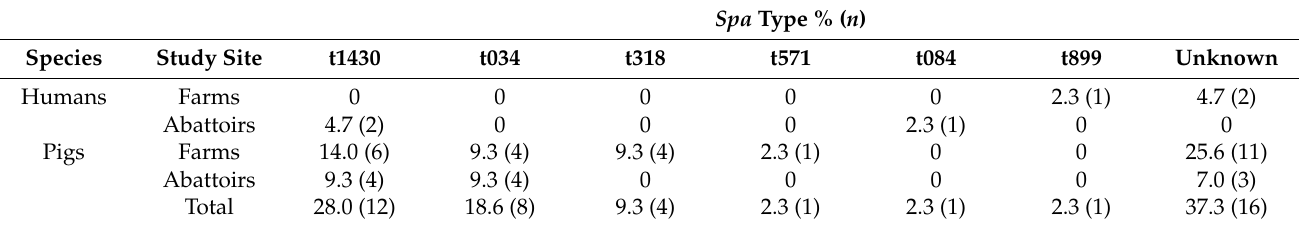
Table 5. Spa type distribution among representative farm and abattoir isolates ( n =